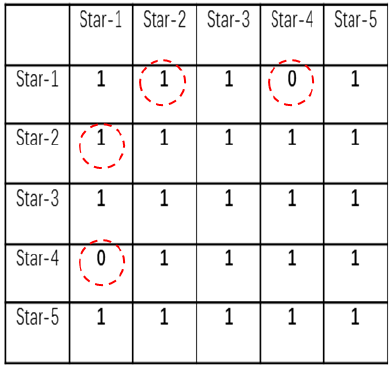
Figure 7. A connection matrix.